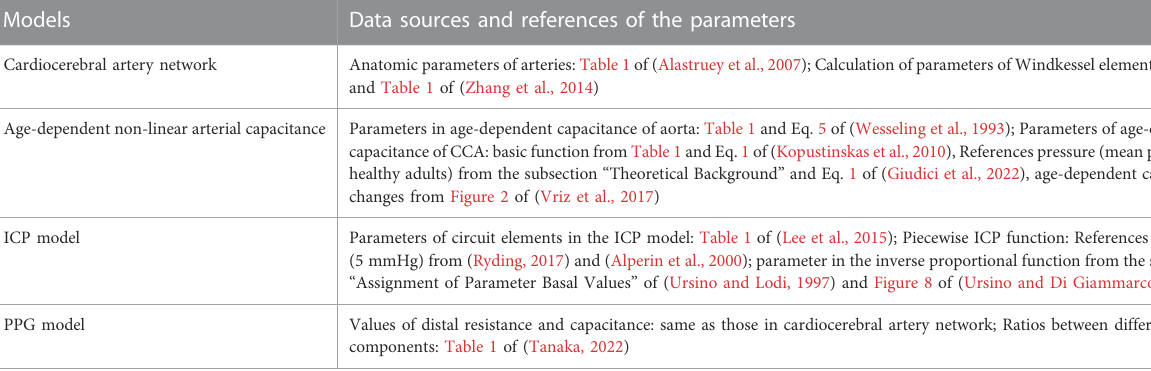
TABLE 1 Data sources of the parameters in the computational models.